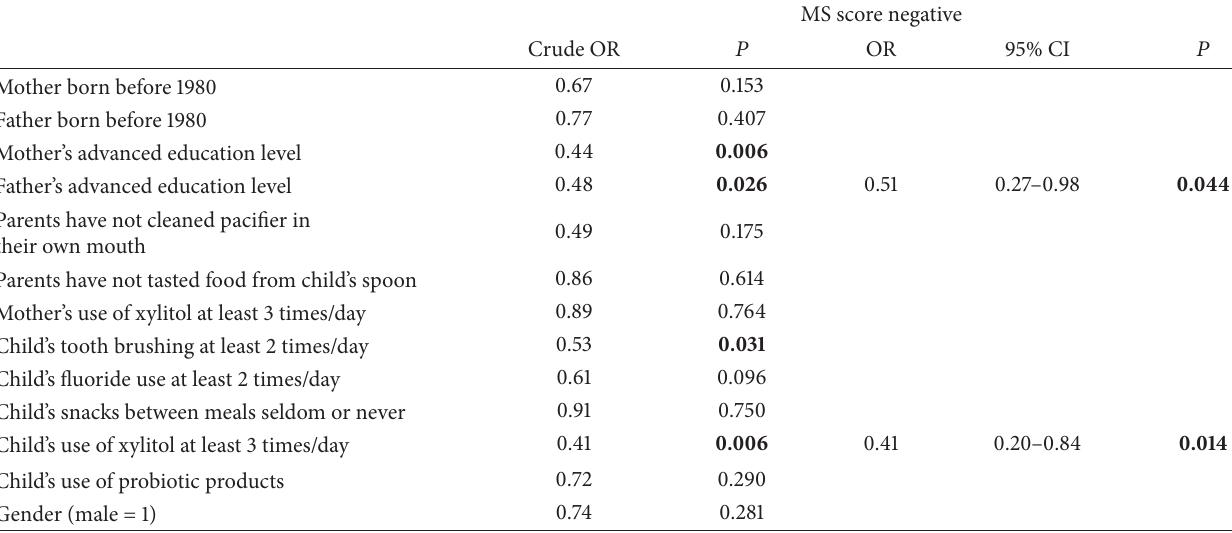
Table 3: Results of the logistic regression models of parent- and child-related factors on the presence of MS among first-born children at the age of 24–36 months with intervention group and area as